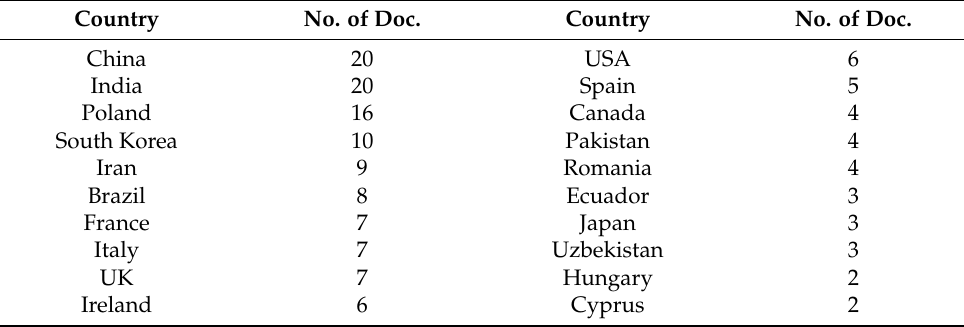
Table 4. Top 20—Most productive countries in the research area (2020–2022).